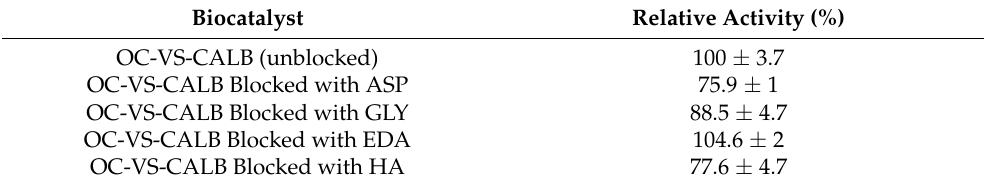
Table 2. Effect of the different blocking agents on OC-VS-CALB biocatalyst. The activity was measuring versus pNPB. The biocatalysts have been incubated for 24 h at pH 8 after incubation step.